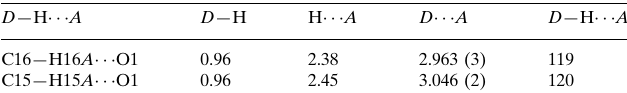
Hydrogen-bond geometry (A˚ , (cid:1)